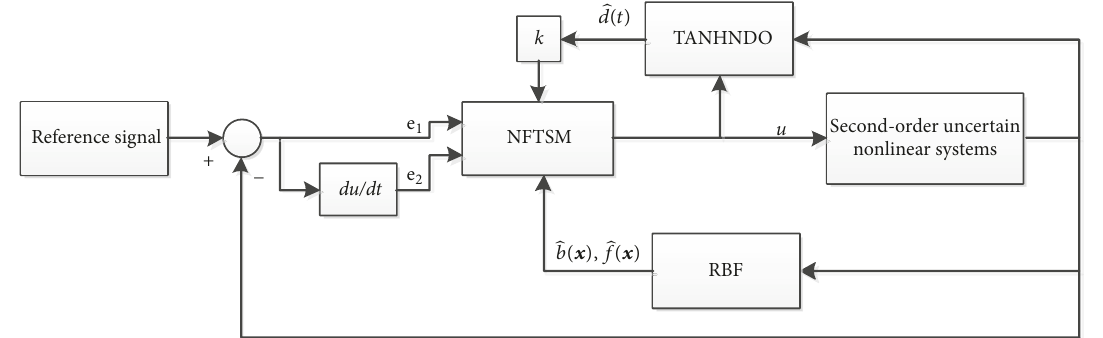
Figure 1: Structure diagram of the system